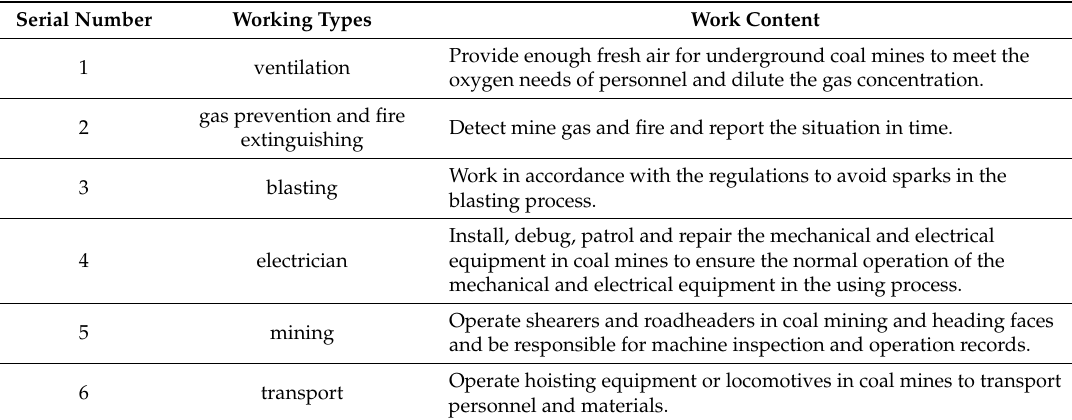
Table 1. Statistics of working types associated with gas explosion